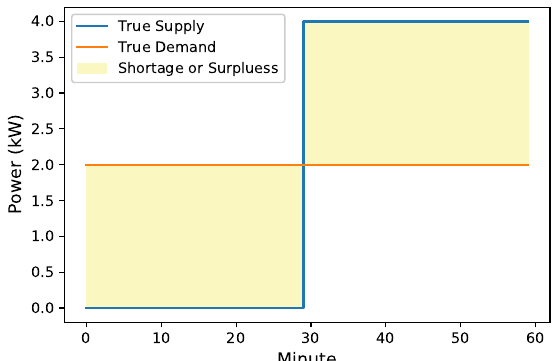
Figure 3. An example of the imperfect overlap between a consumer and a supplier each allocated 2 kWh. In the first half-hour, no supply is available, so there is a shortage of 1 kWh. The supplier’s entire 2 kWh is exported in the second half of the hour, which creates a surplus of 1 kWh. Assuming both agents do not have storage, the shortage and surplus have to be fulfilled by the grid. Thus, 1 kWh is imported at G b , and 1 kWh is exported at G s . This condition creates a net bill deficit because both agents demanded and supplied exactly their allocation, but some energy was exchanged with the grid to resolve the imperfect